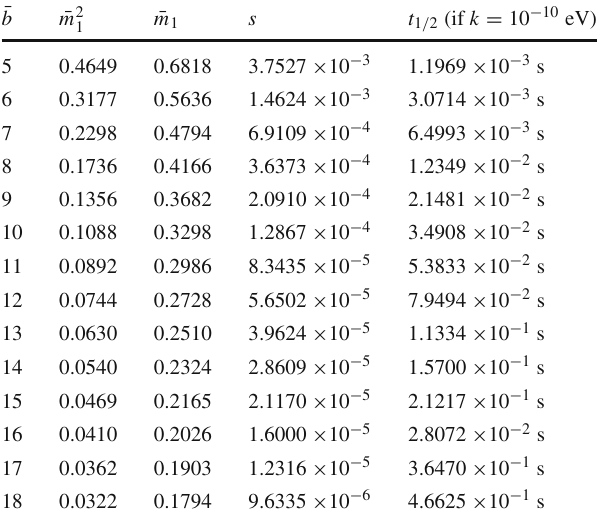
, ¯ m 1 , fitting parameter s , 1